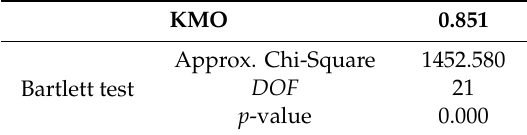
Table 1. Results of KMO and Bartlett testing.